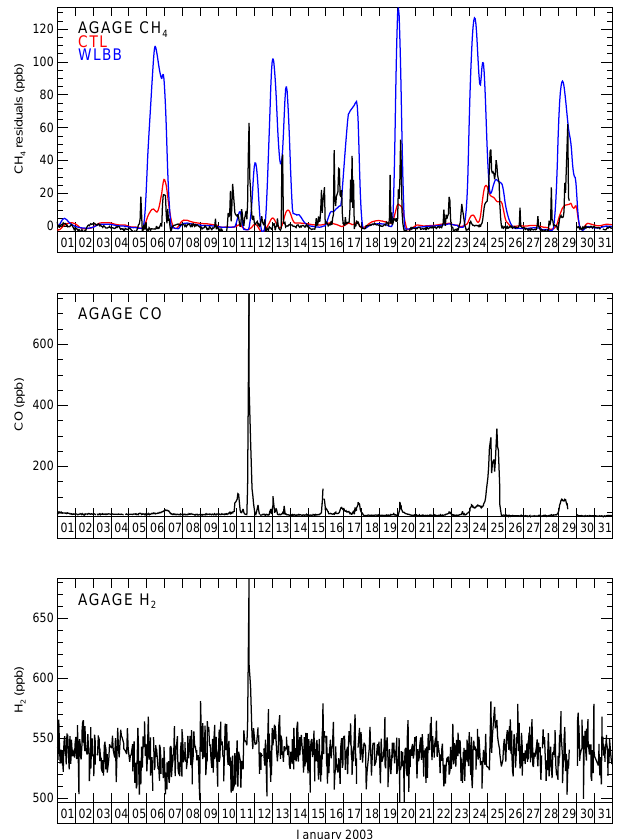
Figure 5. Cape Grim data for January 2003. Upper panel: observed (black) CH 4 residuals; CCAM simulated residuals for tracers CTL (red) and WLBB (blue). Middle panel: observed CO. Lower panel: observed H 2